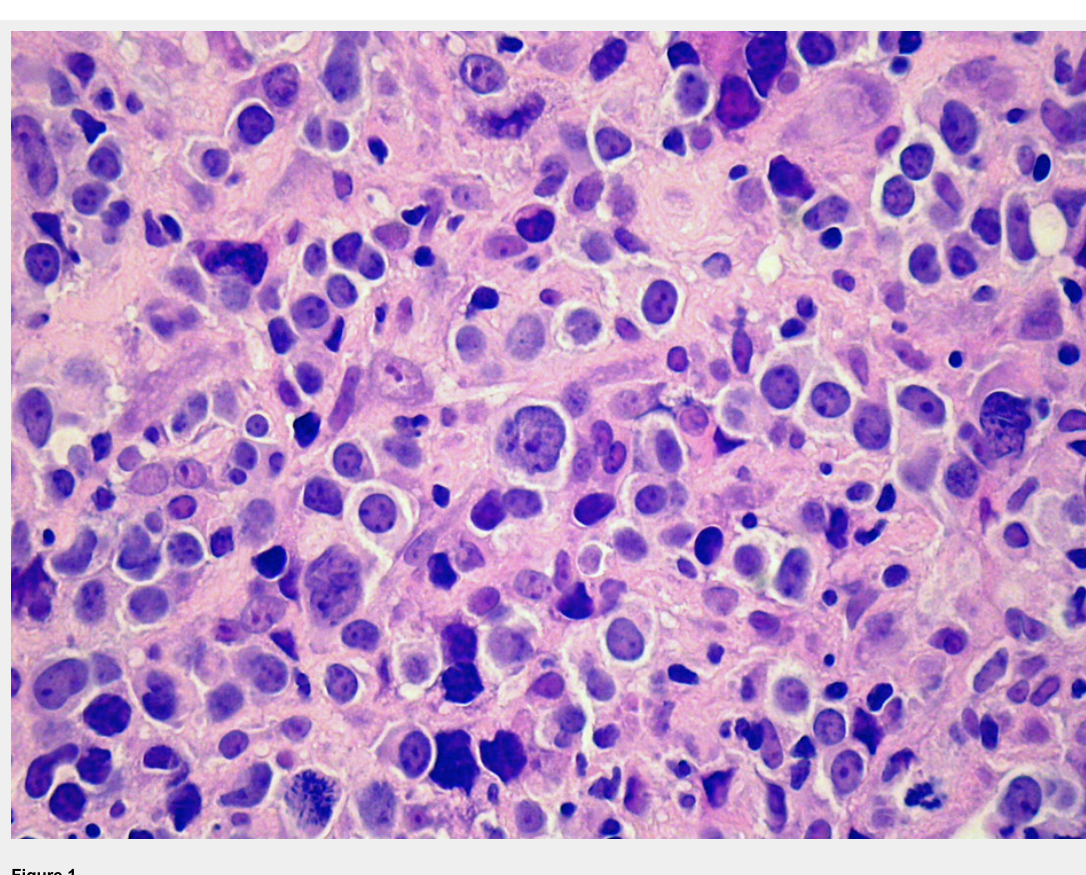
Figure 1 Typical morphological appearance of